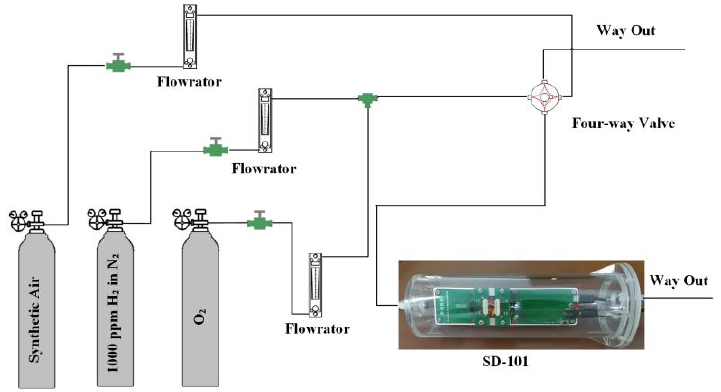
Figure 3. Gas sensing testing device.